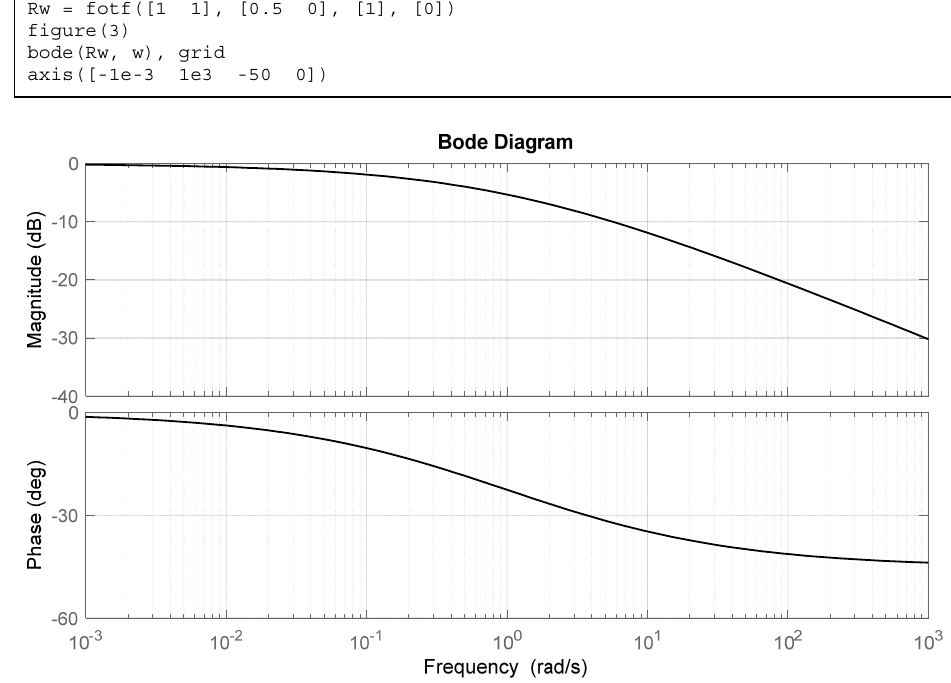
Figure 9. Bode diagram for R ω / R k approximation using fractional order block.